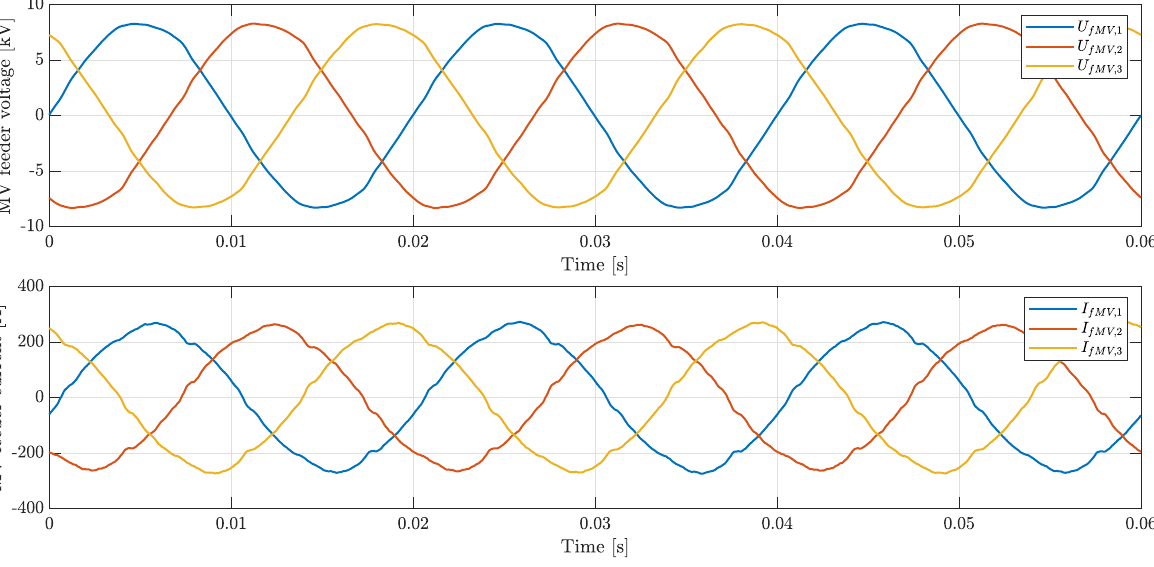
Figure 12. C1—Medium voltage feeder voltage and current after switching on the capacitor stage.